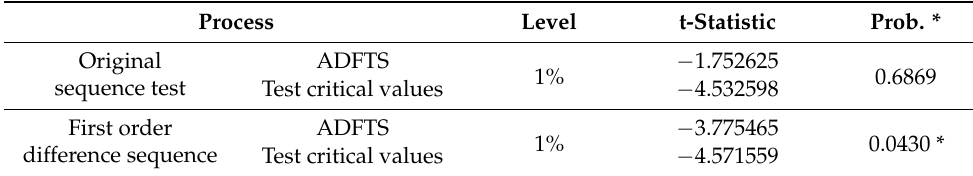
Figure 6. Trend diagram of real values (variable A). Table 6. Unit root test results of actual values (variable